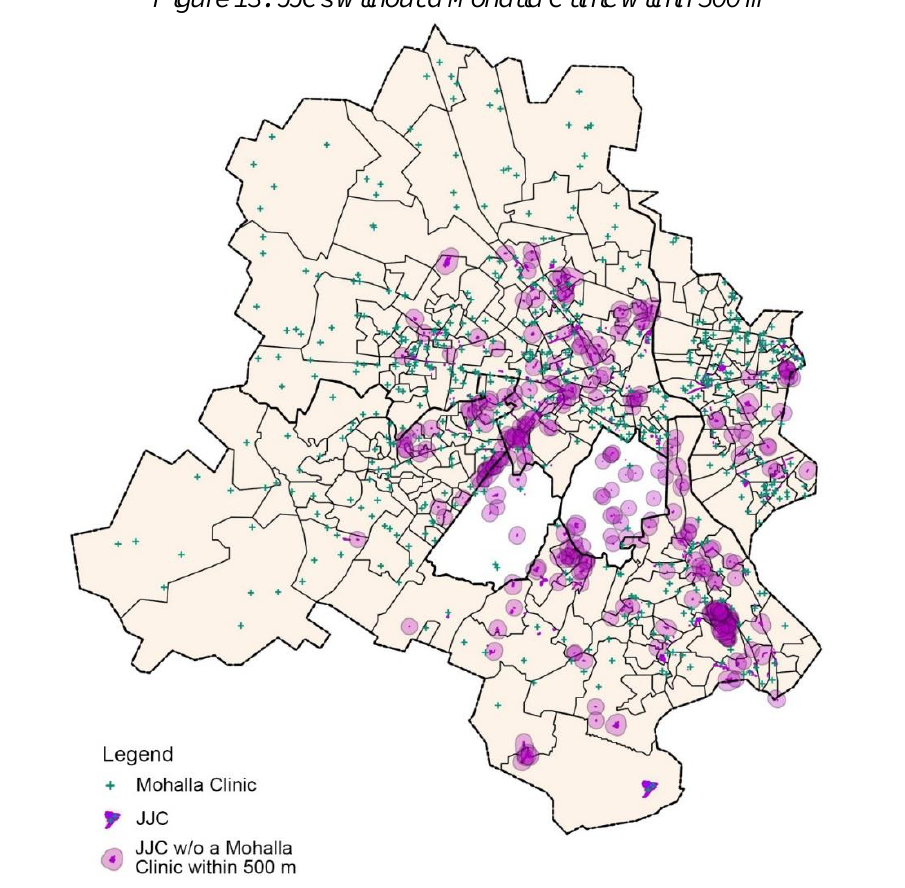
Figure 13: JJCs without a Mohalla Clinic within 500